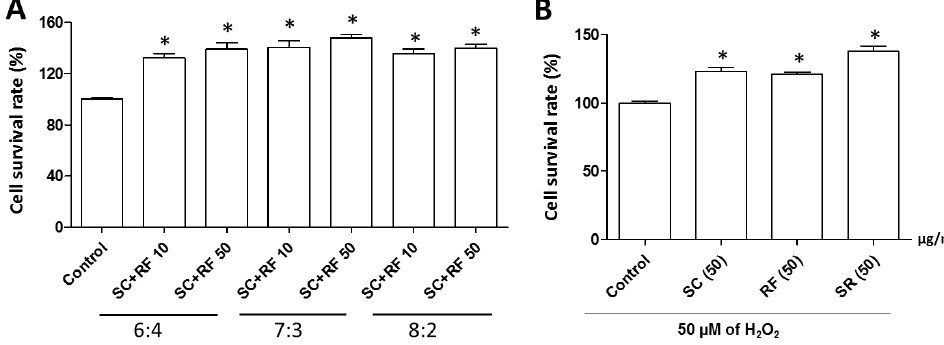
Figure 3. E ff ect of single or combined Schisandra chinensis (SC) and Ribes fasciculatum (RF) extracts on neuronal cell survival rate. PC12 neuronal cells were treated with di ff erent ratios (6:4, 7:3, or 8:2) of SC and RF at concentrations of 10 or 50 µ g / mL ( A ). The e ff ect of single or combined SC and RF extracts (SR) on cell survival rate was compared ( B ). Control is a treatment of 50 µ M of H 2 O 2 . *: p < 0.05 vs.